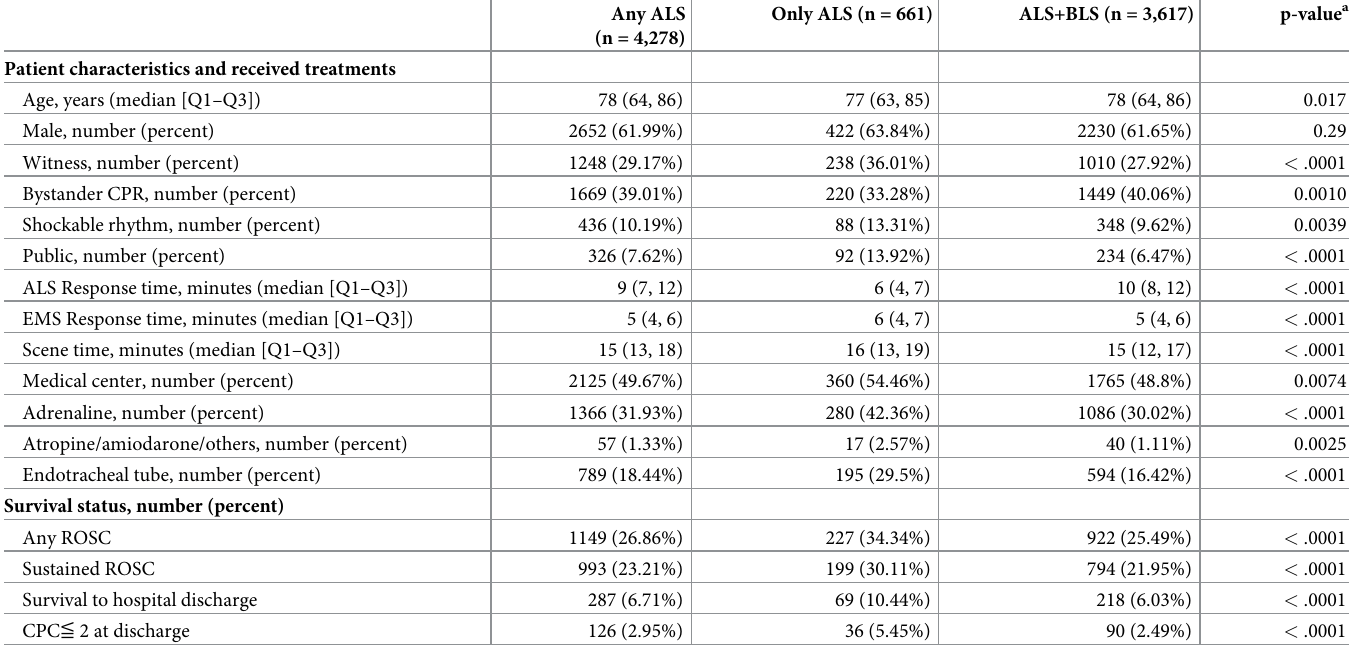
Table 1. Demographic data and outcomes of enrolled out-of-hospital cardiac arrest patients stratified based on disp a tch